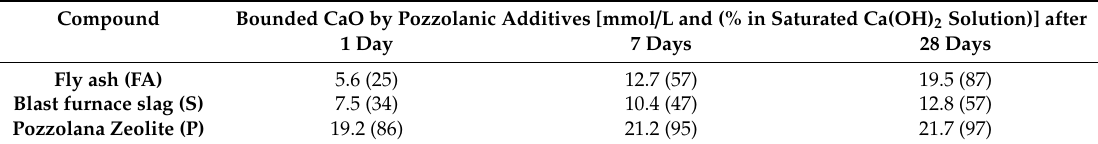
Table 2. Pozzolanic activity of cementitious constituents (by